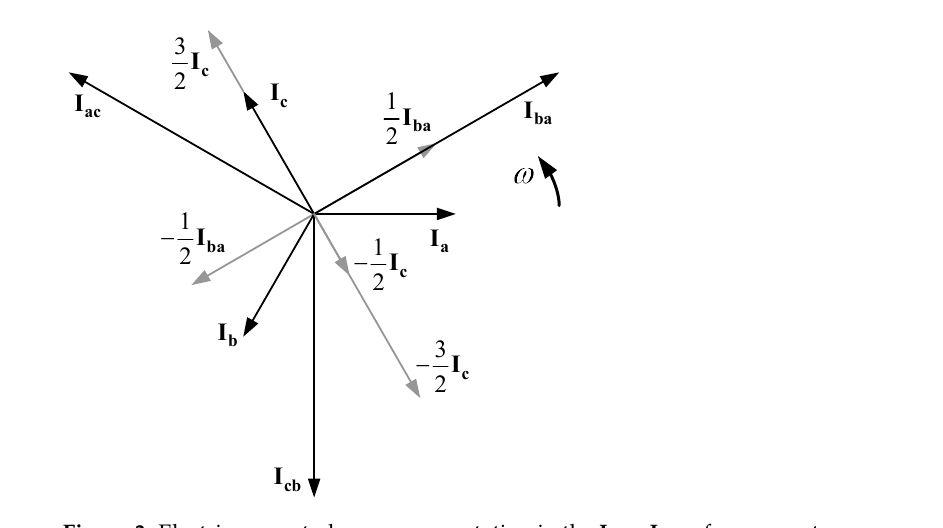
Figure 3. Electric current phasor representation in the I c - I ba reference system.